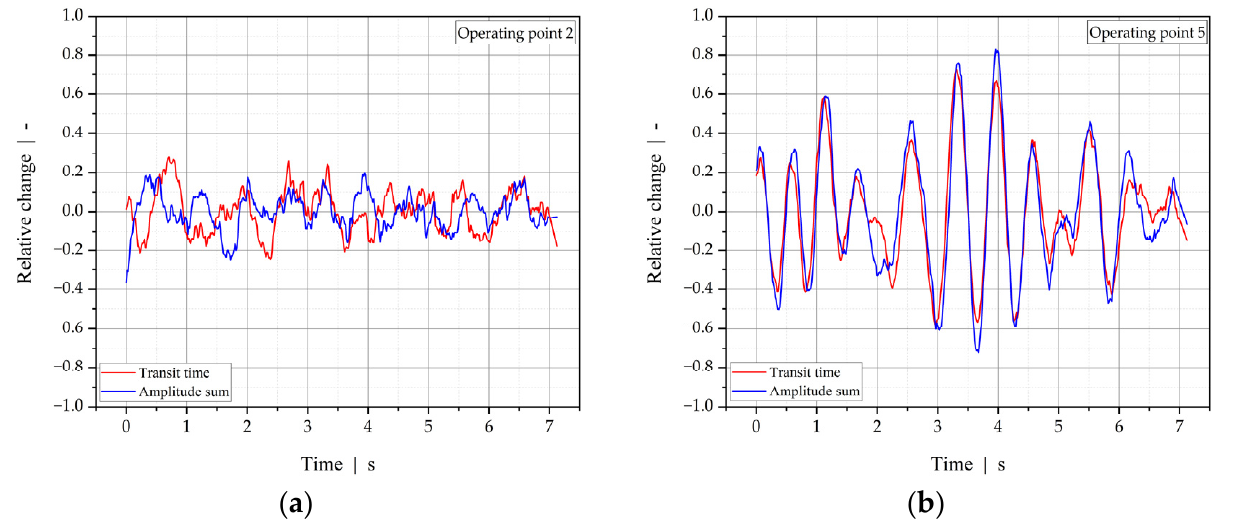
Figure 17. Relative change in transit time and amplitude sum (intensity) at ( a ) operating point 2 and ( b ) operating point 5 in the ultrasound detection of flow instabilities when co-extruding HDPE and an adhesive layer.